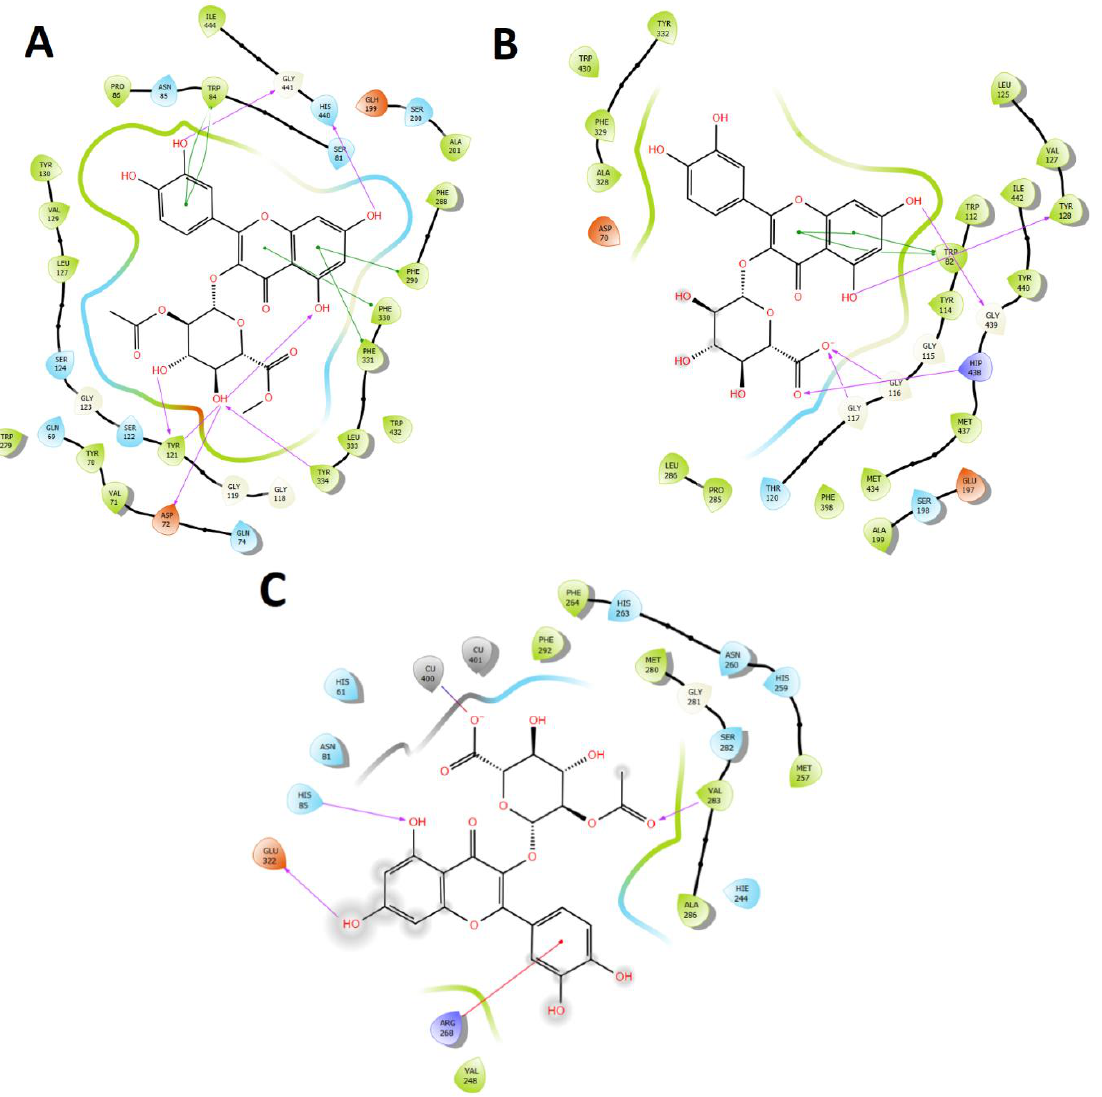
Figure 8. Two-dimensional diagram of ( A ) . Most active compound: Quercetin 3-O-ß-D-2 ″ -acetyl- glucuronide methyl ester (related to docking binding energy) and its main interactions into the ac- etylcholinesterase ( Tc AChE) catalytic site. ( B ) . Most active compound: Quercetin 3-O-(ß-D-glucu- ronide) (related to docking binding energy) and its main interactions into the butyrylcholinesterase ( h BuChE) catalytic site. ( C ). Most active compound: Quercetin 3-O-ß D-2 ″ -acetylglucuronide (re- lated to docking binding energy) and its main interactions into the tyrosinase catalytic site. Purple arrows represents hydrogen bond interactions, green lines represents π - π interactions and red lines represents π -cation interactions. 3. Discussion The use of plants rich in phenolic constituents has been important over the years to prevent neurodegenerative diseases due to the high content of polyphenolics. The ethanolic extract of Lloime showed cholinesterase ( IC 50 = 1.94 ± 0.07 and 2.73 ± 0.05 μg/mL, for AChE and BuChE, respectively) and tyrosinase ( 4.92 ± 0.05 μg/mL ) enzyme inhibition activities and several detected flavonoids and coumarin are the probable responsible constituents for the reported activity. The plant also showed potent antioxidant capacity (Table 2) by several complementary assays. Regarding the metabolites identified in the ethanolic ex- tract of O. pillopillo, some reports have indicated that, for example, the presence of cou- marins such as daphnetin and daphnin are cholinesterase inhibitors helpful in Alz- heimer’s disease [19] , can also be active in the treatment of Parkinson’s disease [20], as well as cancer [21], and show other interesting activities in which oxidative stress may be involved. Those compounds were regarded as antibacterial, antifungal, antothrombotic, antiinflammatory, and can inhibit the enzymes cyclooxygenase, lipooxygenase and mon- oamine oxidase (MAO) [20]. Regarding the other compounds identified in the extract of this plant, glycosylated quercetin derivatives such as quercetin 3-O-glucuronide and iso- rahmnetin-3-O-glucuronide were reported to show acetylcholinesterase inhibitory activ- ity, with IC 50 values of 8.2 and 23.2 μM, respectively [22], those compounds also showed anti tyrosinase activity [23]. In this research,. we found cholinesterase and tyrosinase in- hibitory activities of the ethanolic extract and all detected derivatives mentioned above showed good binding energies over acetylcholinesterase, even comparable to the refer- ence compound galantamine in the docking calculations, including the reported toxic com- pound 8-O-methyl daphnin (daphnetin 7 O-(5 ″ -O-methyl-glucose), 8-methyl ether), which showed a binding energy value of −12.651 kcal/mol suggesting that this compound could exert a good acetylcholinesterase inhibition. The ethanolic extract of this plant showed po- tential for the preparation of nutraceuticals or natural remedies .